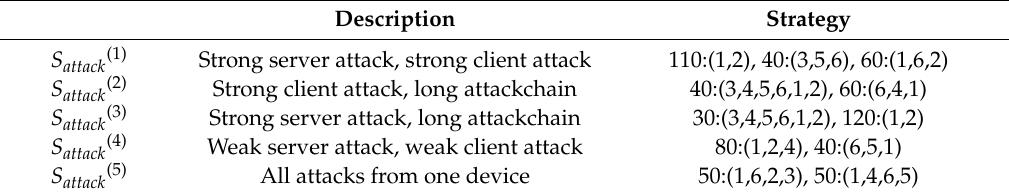
Table 2. Attack strategies.